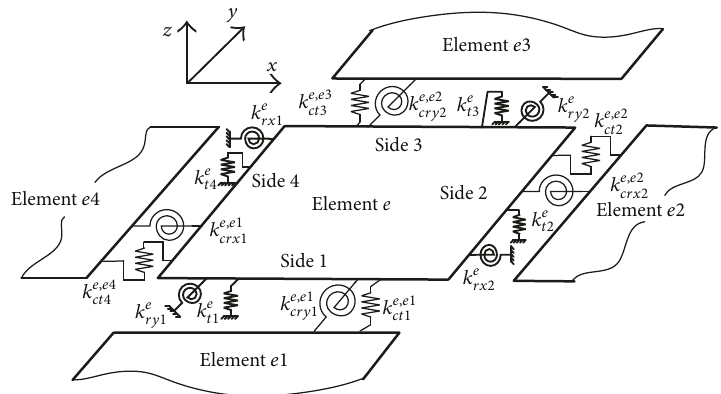
Figure 1: The coupling relationships between element e and four adjacent